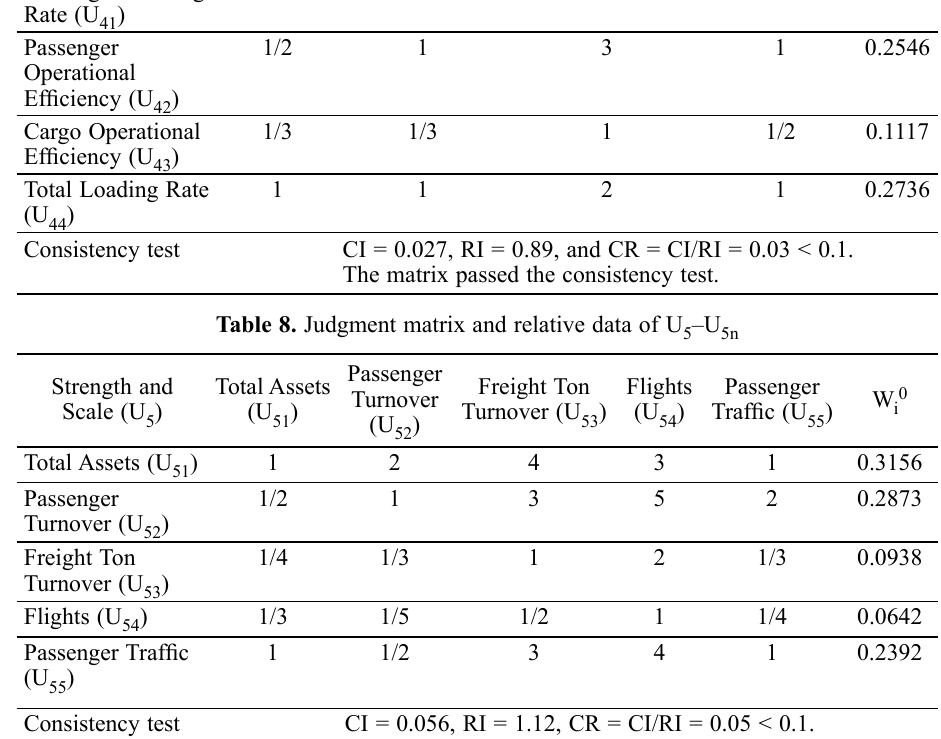
Table 7. Judgment matrix and relative data of U